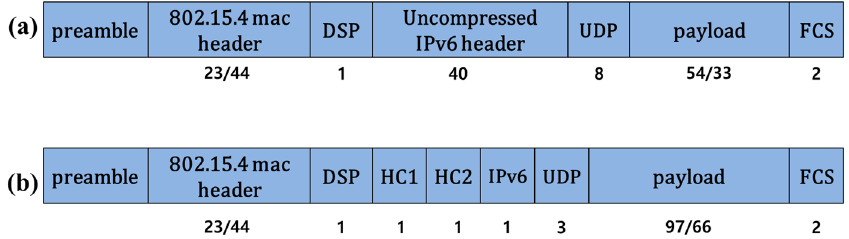
Figure 5. The compression technique of IPv6 over Low power Wireless Personal Area Network (6LoWPAN) .